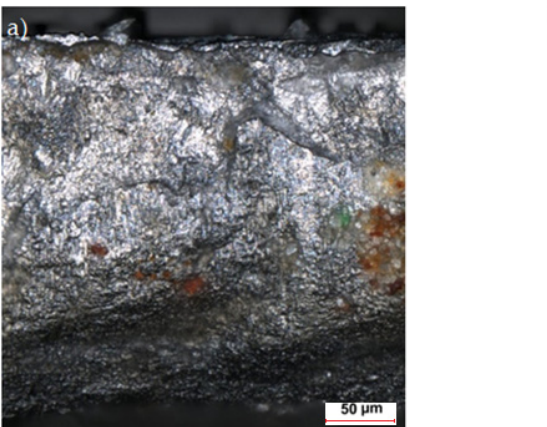
Figure 5. Views of the surface of the cut edge ( h c = 0.08 mm and v = 10.2 m/min): ( a ) surface pho- tography, ( b ) surface topography (uncoated steel).